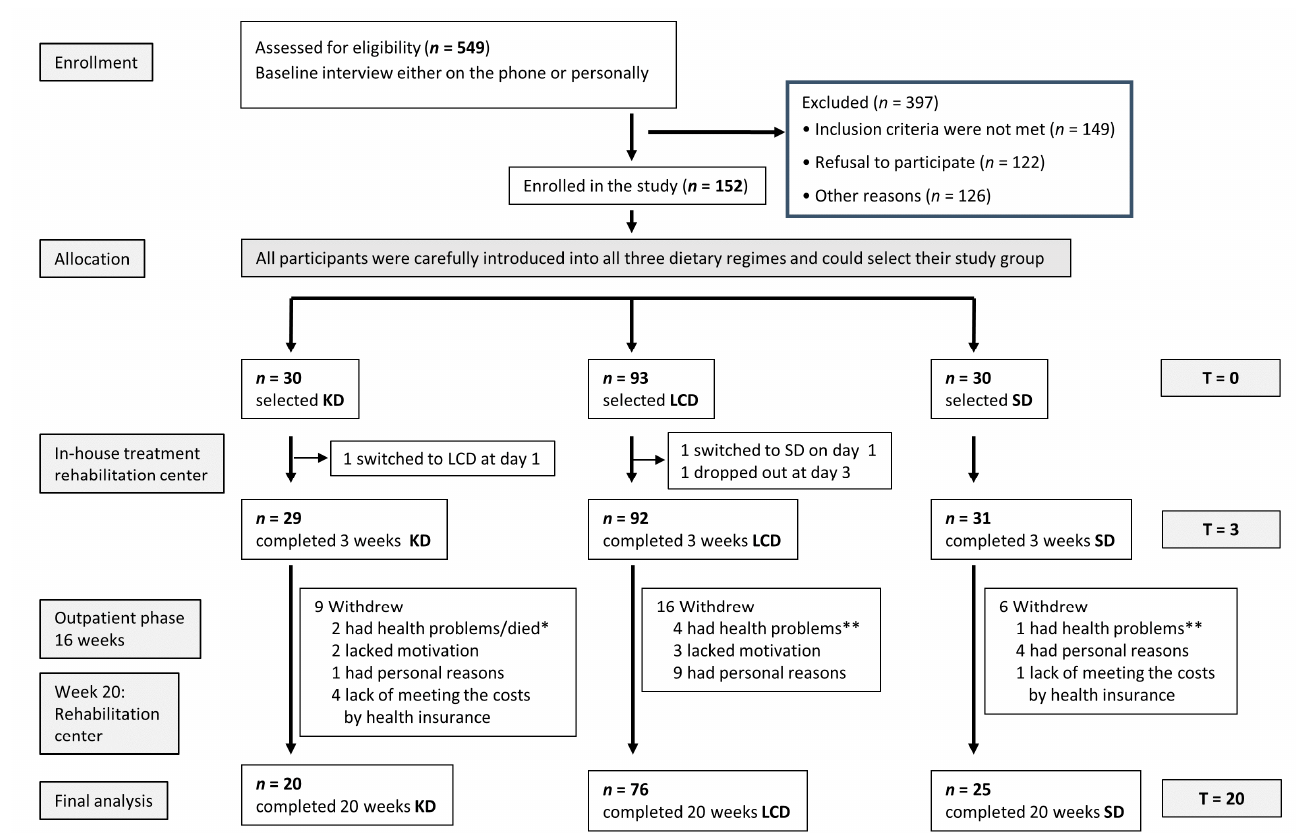
Figure 1. Flow chart of the study. This analysis focuses on a comparison between week 0 (T0) and week 20 (T20). * 1 patient had to resume chemotherapy directly after T3 due to progress, one died because of advanced metastatic disease. ** Patients reported health problems without further specification. KD: ketogenic diet; LCD: low carb diet; SD: standard diet.